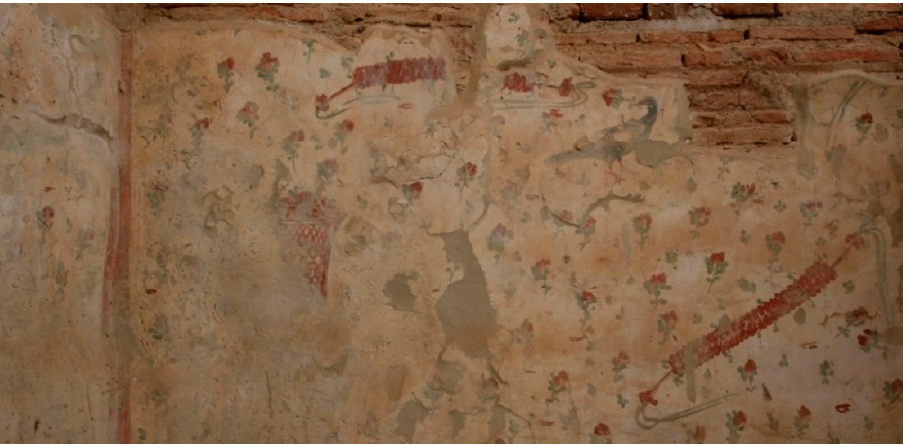
Figure 27. Ephesus, Hanghauser 2. Author photo.